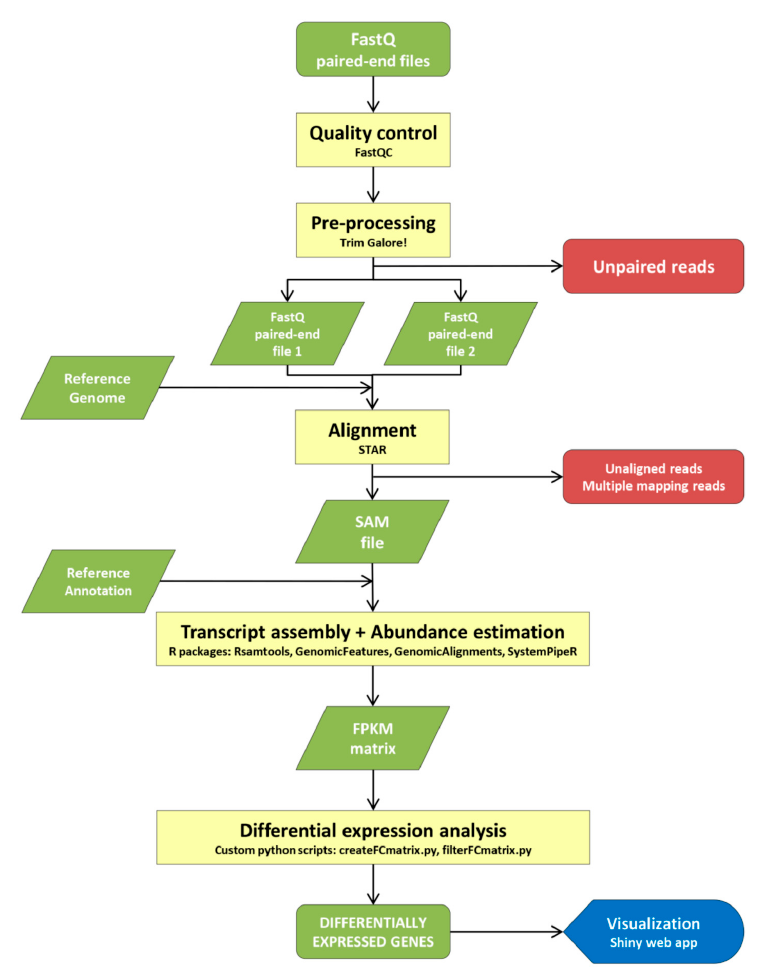
Figure 2. RNA-seq bioinformatics protocol used to identify di ff erentially expressed genes in common bean.